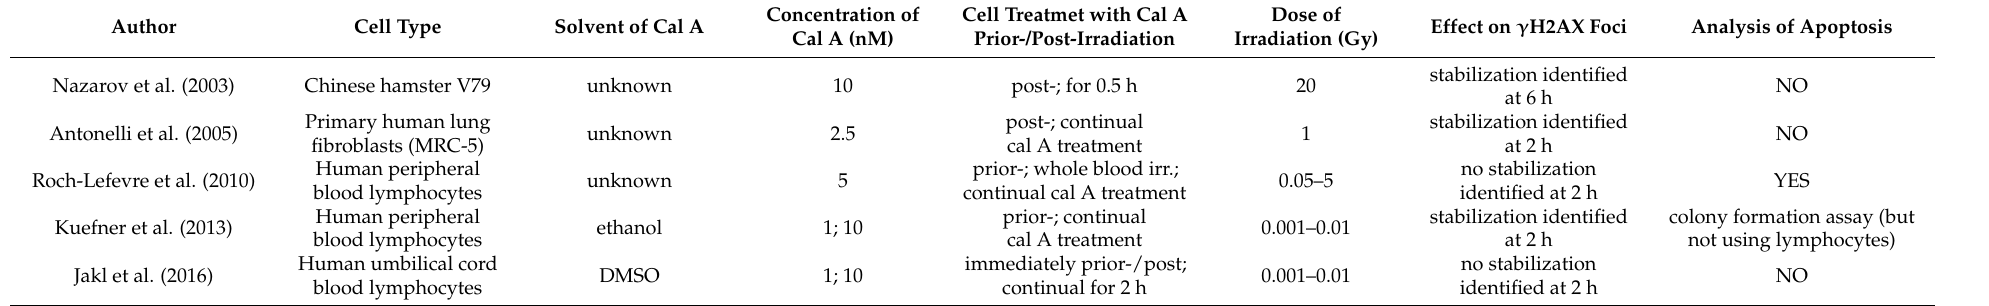
Table 3. Methodological information on studies investigating the effect of cal A on radiation-induced γ H2AX